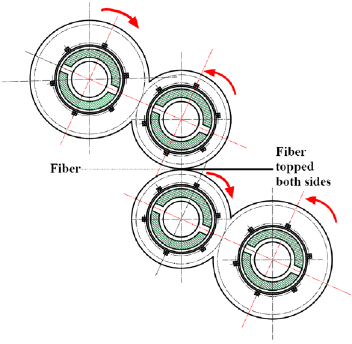
Figure 4. The S-type four-roll calender.